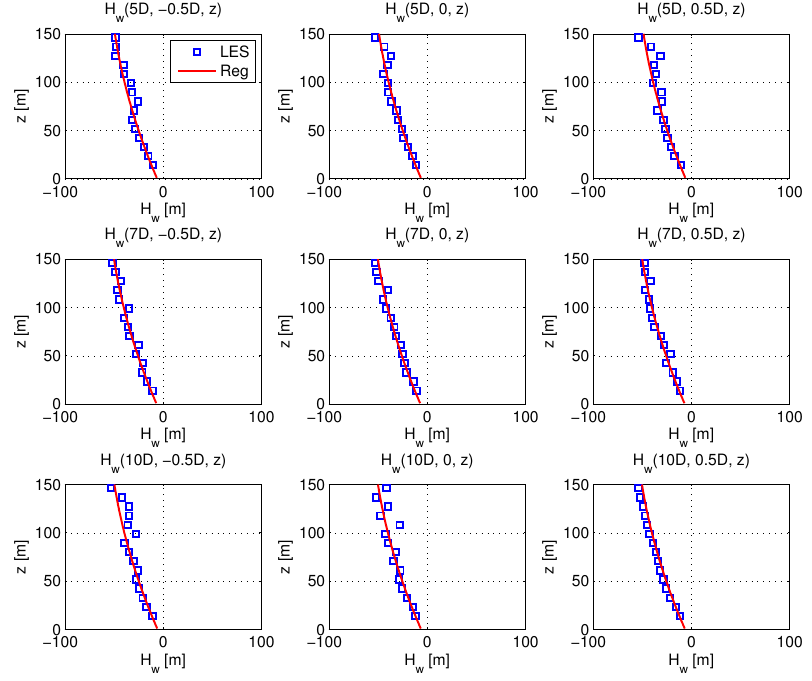
Figure 26. Spatial variation of H w : LES versus regression-based